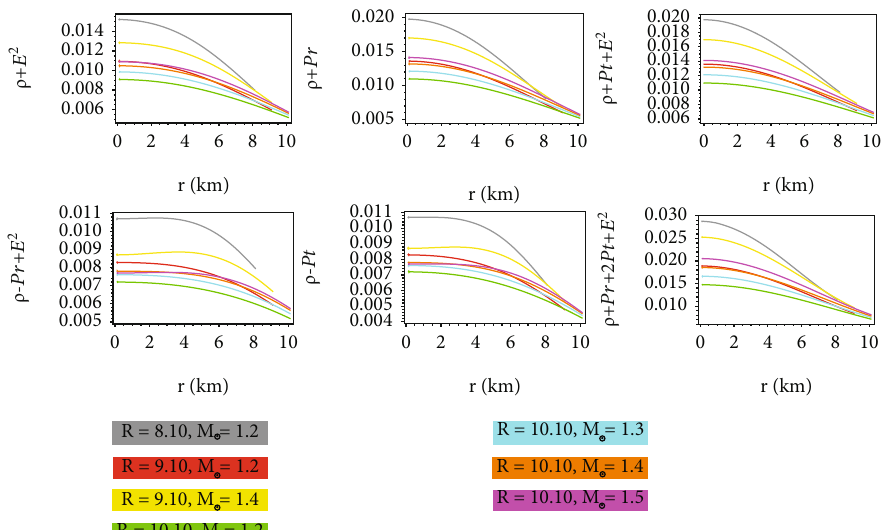
Figure 6: Evolution of energy conditions for our proposed model.